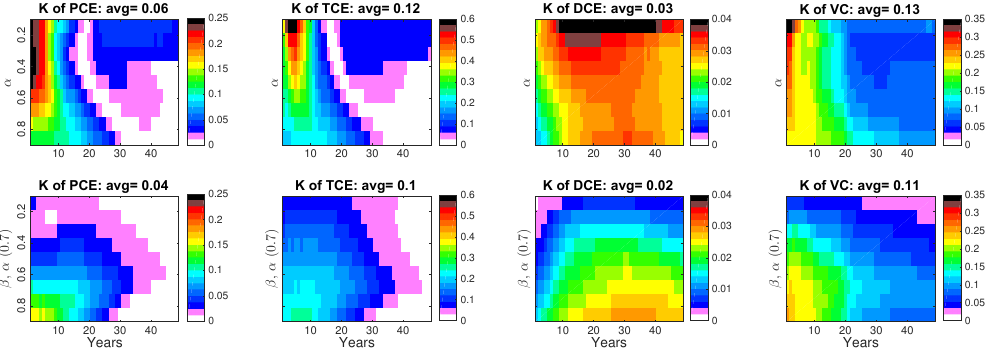
Figure 10. Images showing the MSE of PCE, TCE, DCE and VC degradation rates in time. These are obtained using the hybrid EnKF-OI scheme for (1) different α values (top panels) and (2) different β values keeping α fixed and equal to 0.7 (bottom